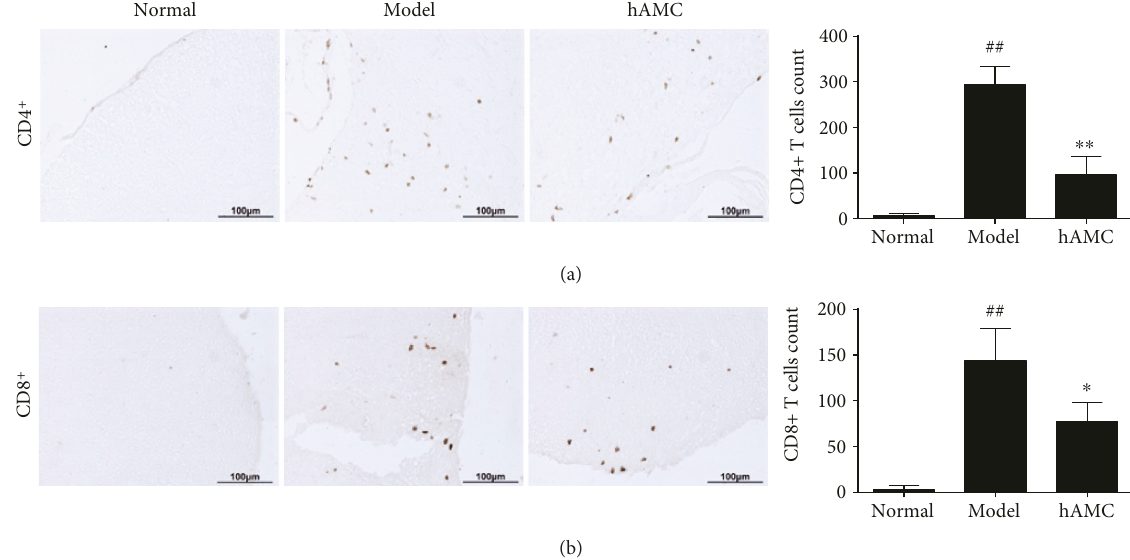
Figure 4: hAMC decreases CD4+ T cells and CD8+ T cells in the CNS of EAE mice. (a) The changes of CD4+ T cells in the spinal cords. (b) The changes of CD8+ T cells in the spinal cords. Left, representative images. Scale bars, 100 μ m. Right, the quantitative analysis. Six fi elds were evaluated for each slide. The numbers of positive cells per mm 2 of the spinal cord tissues were made by manual counting at Image-Pro Plus 6.0 software. Data were mean ± SD. n = 8 mice per group. ## P < 0 01 , compared to normal group. ∗ P < 0 05 , compared to model group, ∗∗ P < 0 01 , compared to model